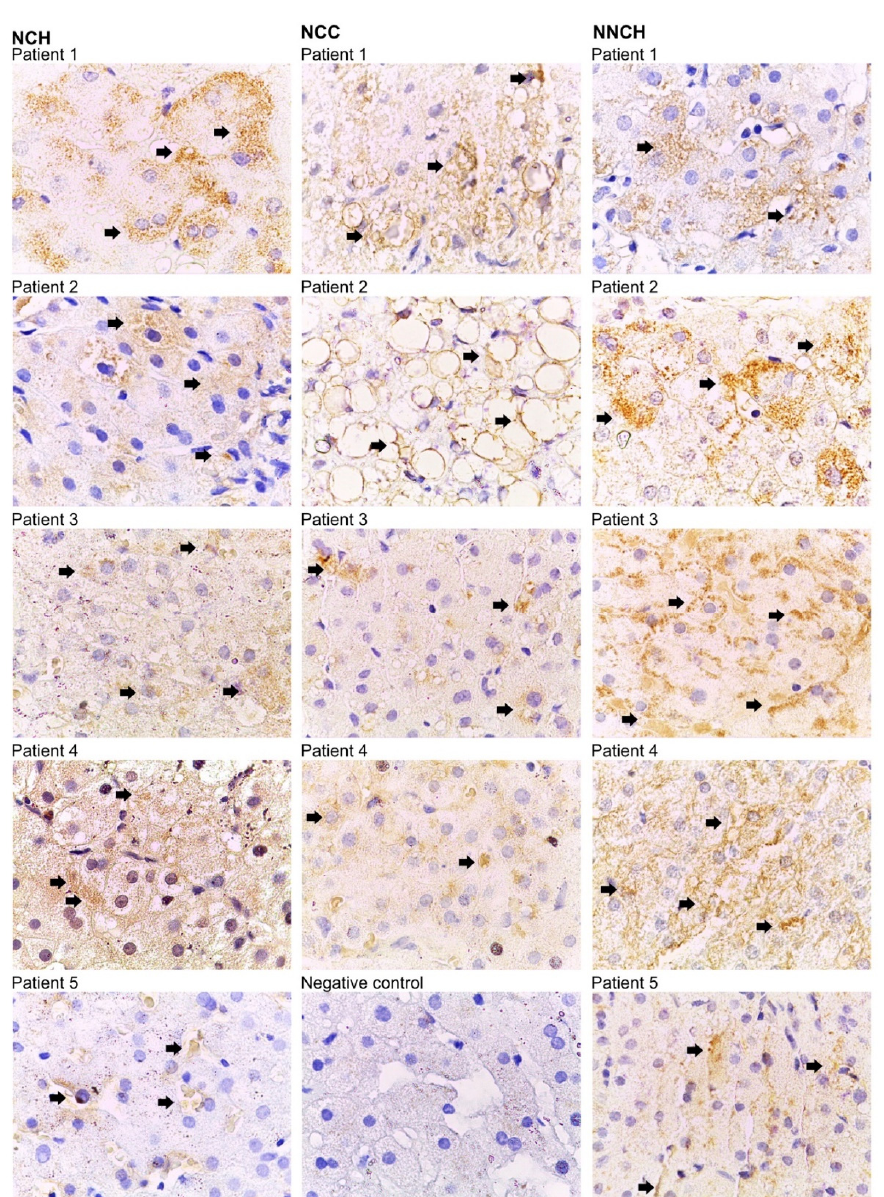
Figure 2. Immunostaining for Z ‐ AAT polymers with D11 antibody. Bound antibodies were visual ‐ ized using HRP ‐ DAB (3,3 ′‐ diaminobenzidine tetrahydrochloride) staining. Arrows indicate Z ‐ AAT polymer ‐ positive areas within hepatocytes (brown color). Images are representative for 7 to 10 taken from different areas of each specimen. Images were taken at 1000 ‐ fold magnification using 100x oil